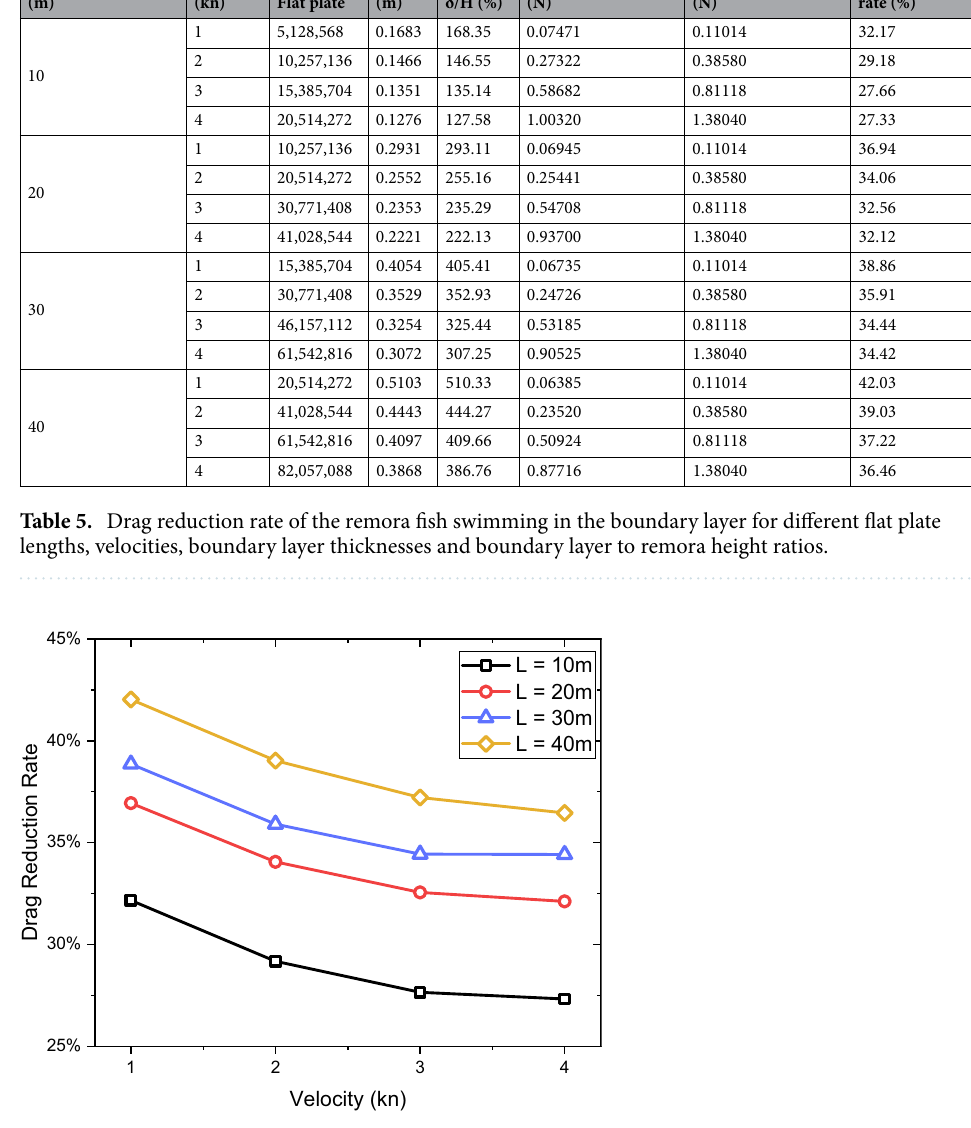
Figure 12. The drag reduction rate vs. the incoming velocity as attached on different locations from the leading edge of the flat